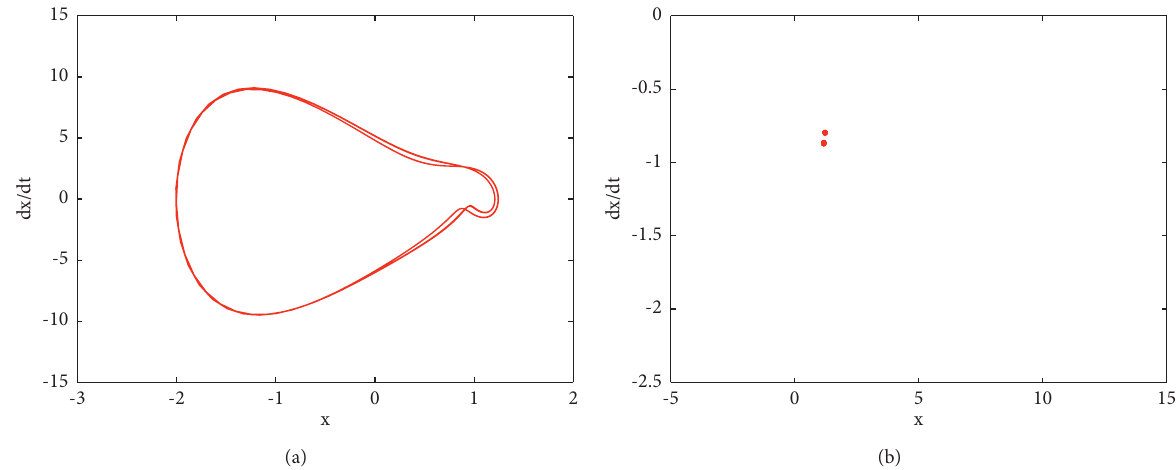
Figure 9: Phase portrait and Poincar´e cross section diagram of the system at F � 45.5 and τ � 1.2. (a) Phase portrait. (b) Poincar´e cross section diagram ( c � 0.5, c 1 � 30, c 2 � 20, μ � 0.001, k 1 � 10, and ω �